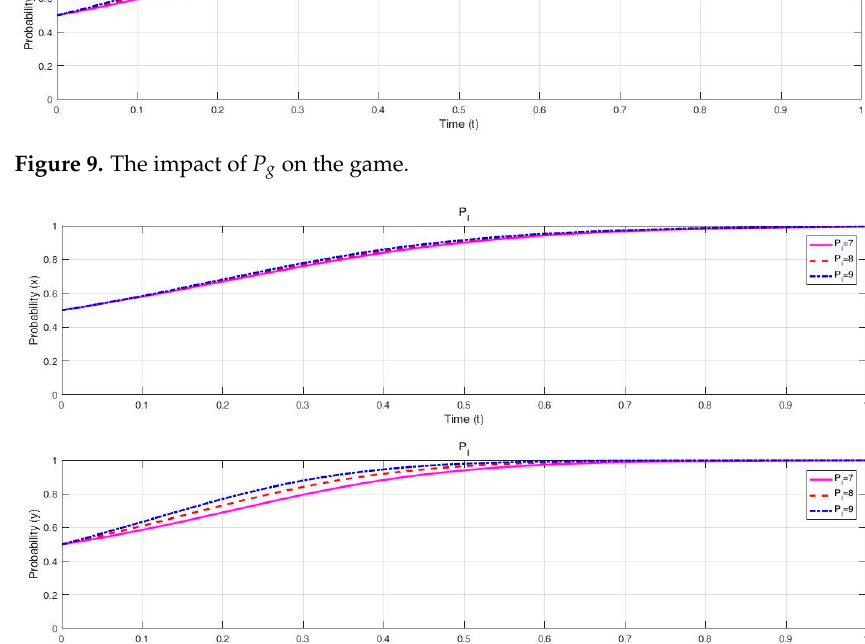
Figure 10. The impact of P l on the game.